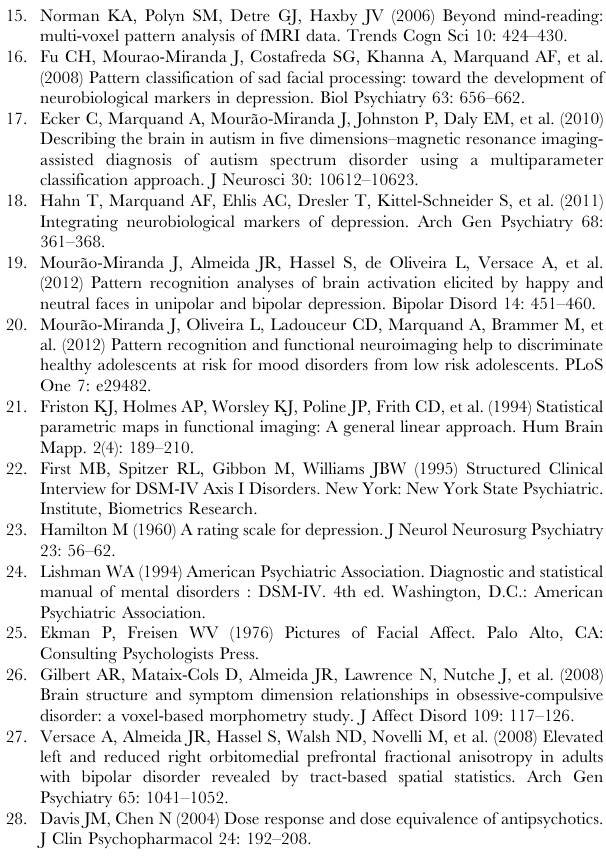
Table S1 Within-group decoding accuracy using the ‘‘standard’’ pattern recognition framework, i.e., train- ing with HC and DP separately to make predictions to HC and DP, respectively. Table S2 Confusion matrix to discrimination Sad versus Neutral in the Healthy Control sample. Table S3 Confusion matrix to discrimination Sad versus Neutral in the Depression Patients sample. Table S4 Confusion matrix to discrimination Happy versus Neutral in the Healthy Control sample. Table S5 Confusion matrix to discrimination Happy versus Neutral in the Depression Patients sample. Text S1 Supplemental